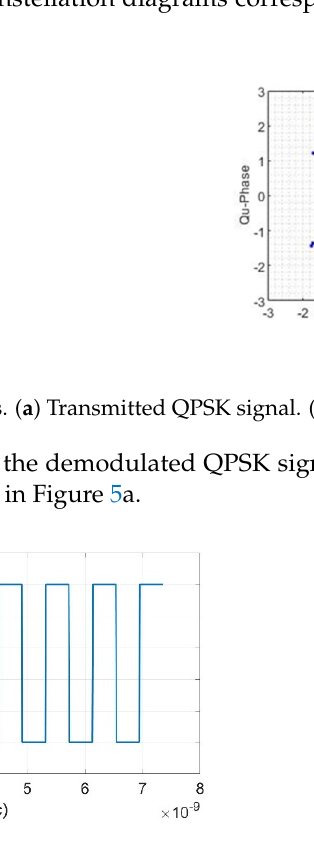
Figure 9. Demodulated signal.